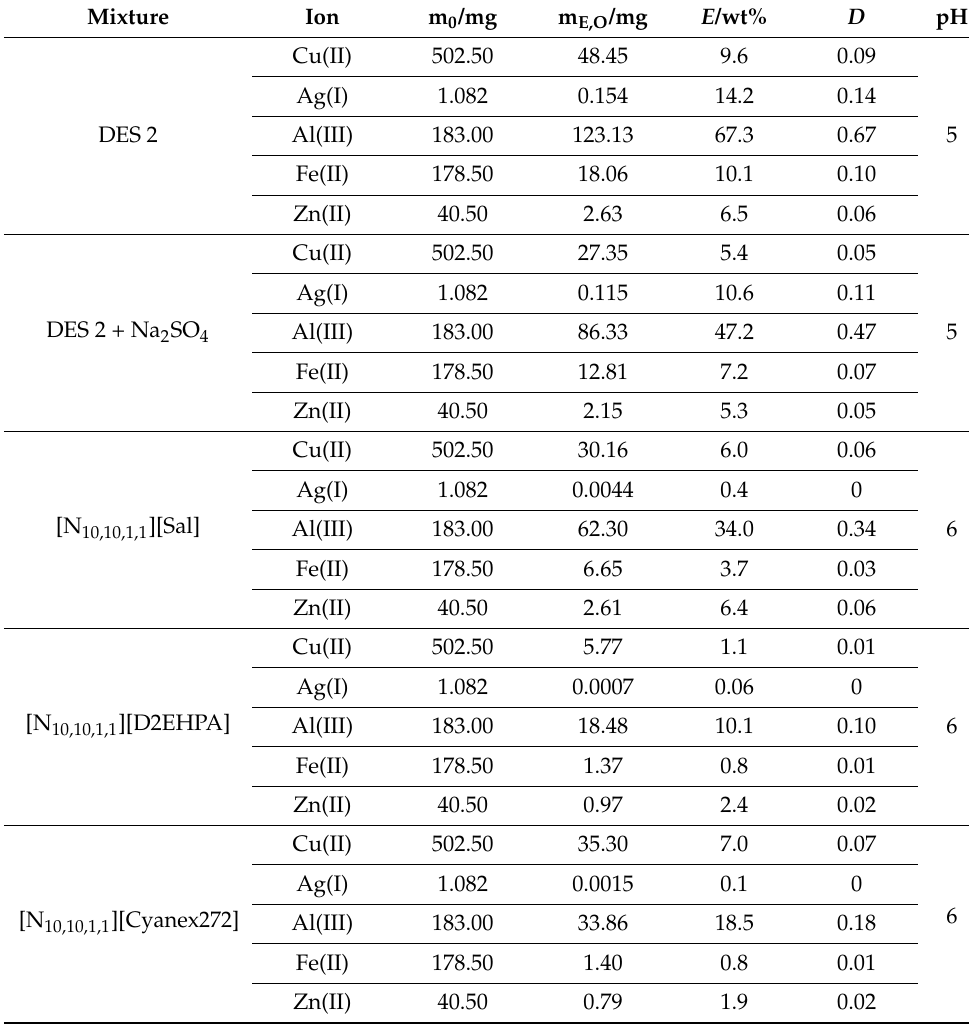
Table 10. Results of metals extraction from the solid WPCBs material after thermal pre-treatment ( T = 1023 K, 7 h), with DES 2 and bi-functional ILs, extraction efficiency ( E /wt%), distribution ratio ( D ) and pH of the aqueous phase after